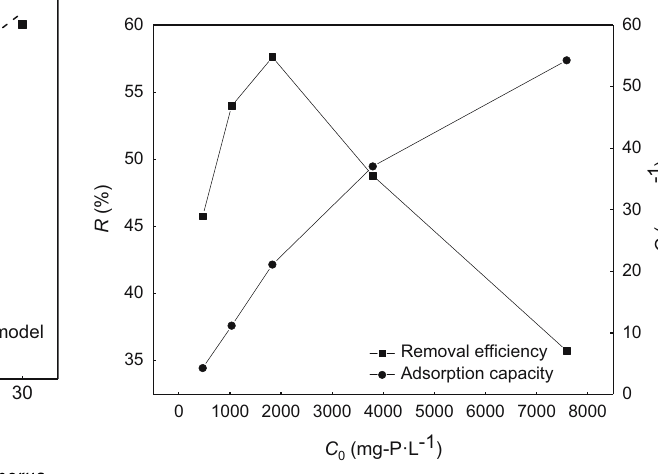
Figure 7: E ff ect of initial concentration on phosphorus removal.